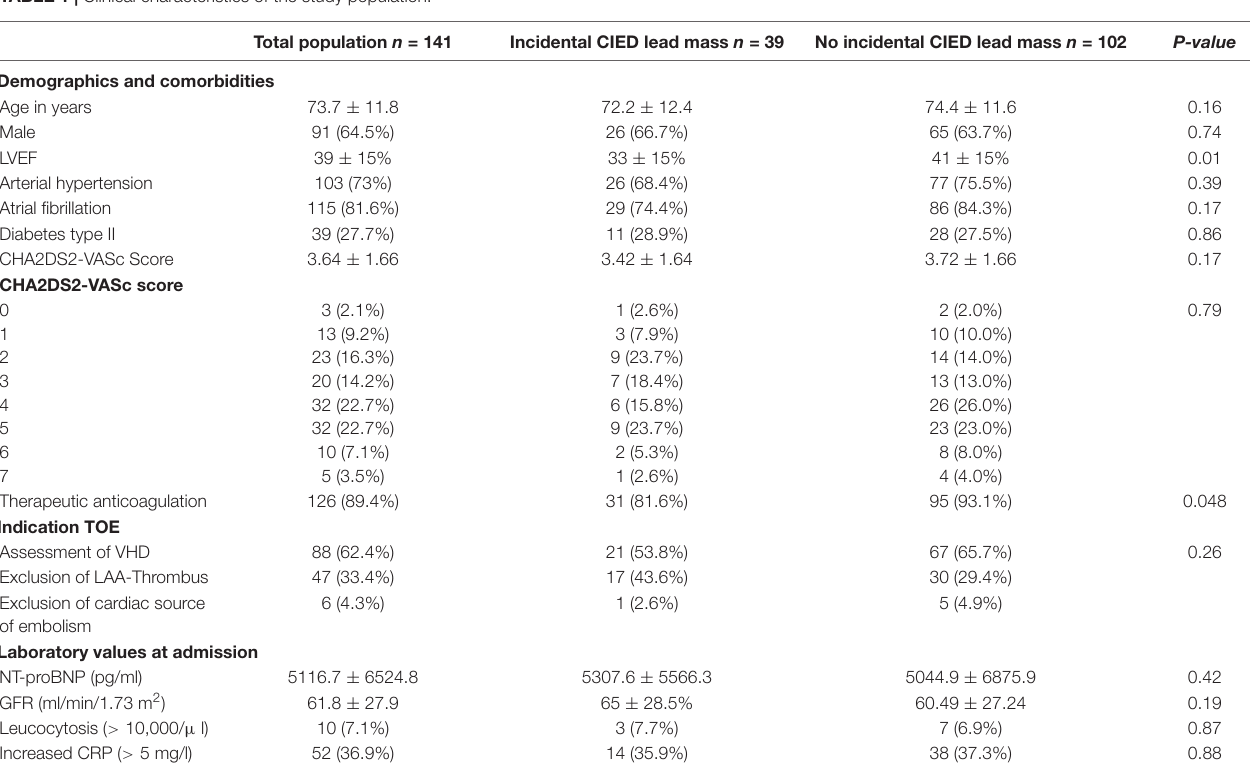
FIGURE 1 | Graphic illustration of study design. CIED, cardiac implantable electronic device; TOE, transoesophageal echocardiography. TABLE 1 | Clinical characteristics of the study